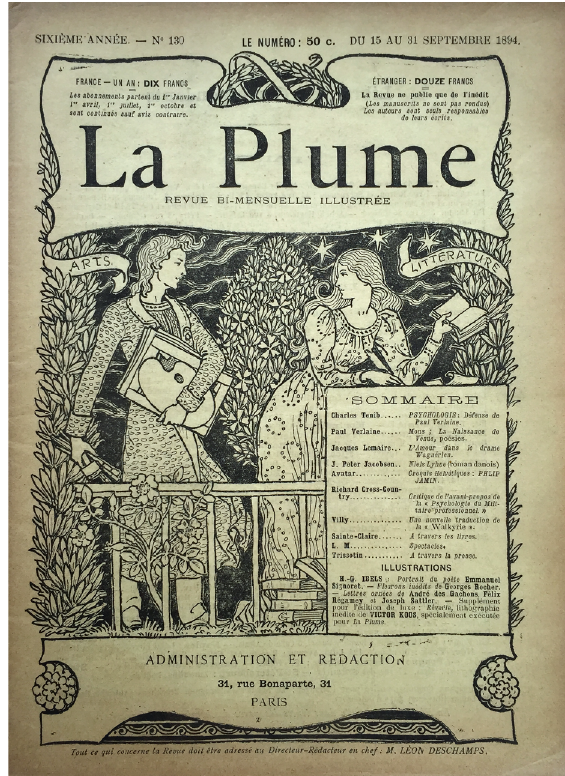
Fig. 3 Eugène Grasset, La Plume (15 September 1894), front cover.